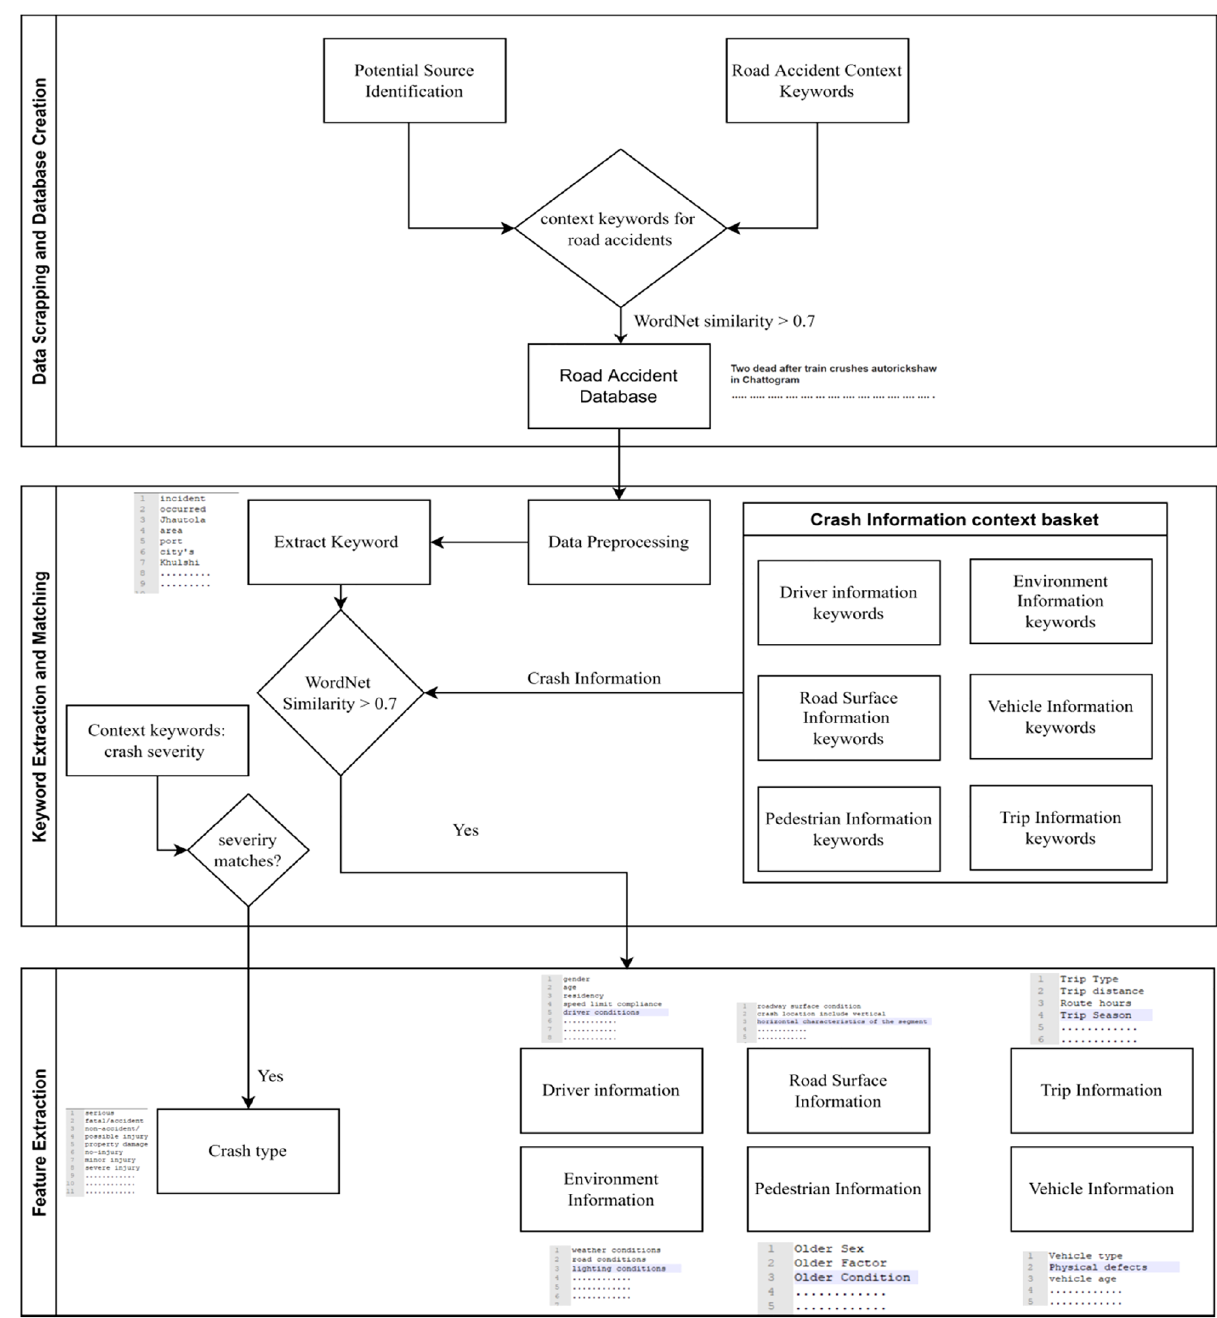
Figure 1. Overview of crash data collection from daily newspaper